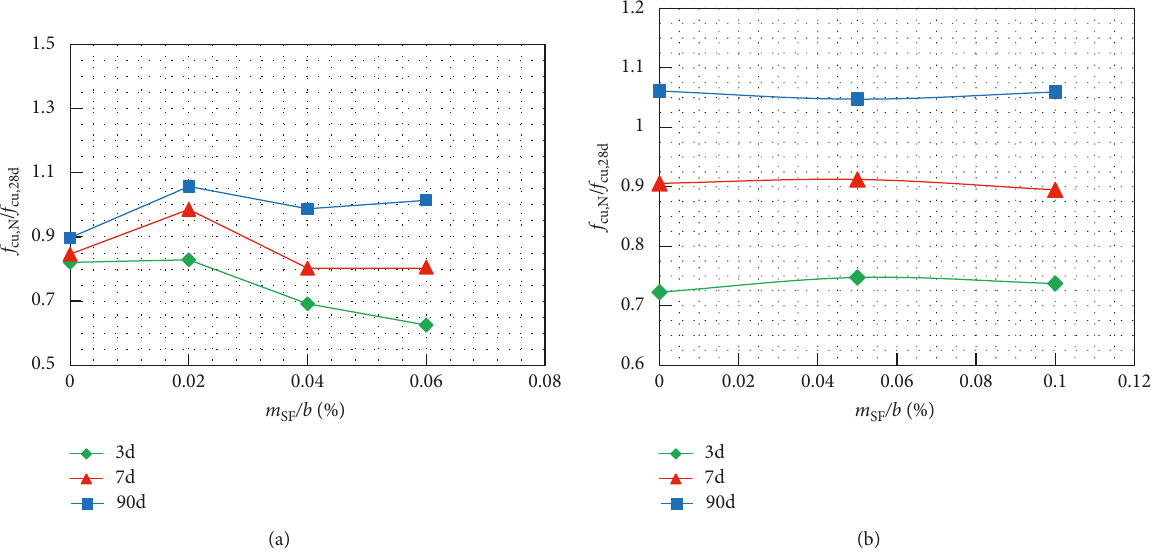
Figure 11: Effect of (m) SF /(b) on (f) cu,N /(f) cu,28d . (a) f cu,N /f cu,28d versus mSF/b [27] and (b) f cu,N / f cu,28d versus m SF / b